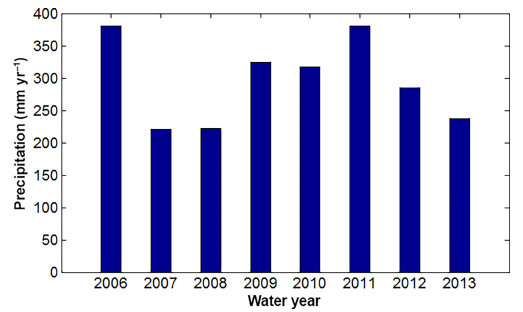
Figure 12. Annual precipitation amount calculated at Boise Air Ter- minal (station ID: 7268104131). Precipitation is calculated based on water year since irrigation in each calendar year is mainly affected by the precipitation during the spring and previous